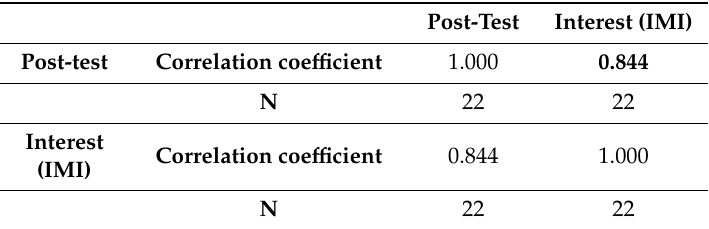
Table 11. Spearman’s rank